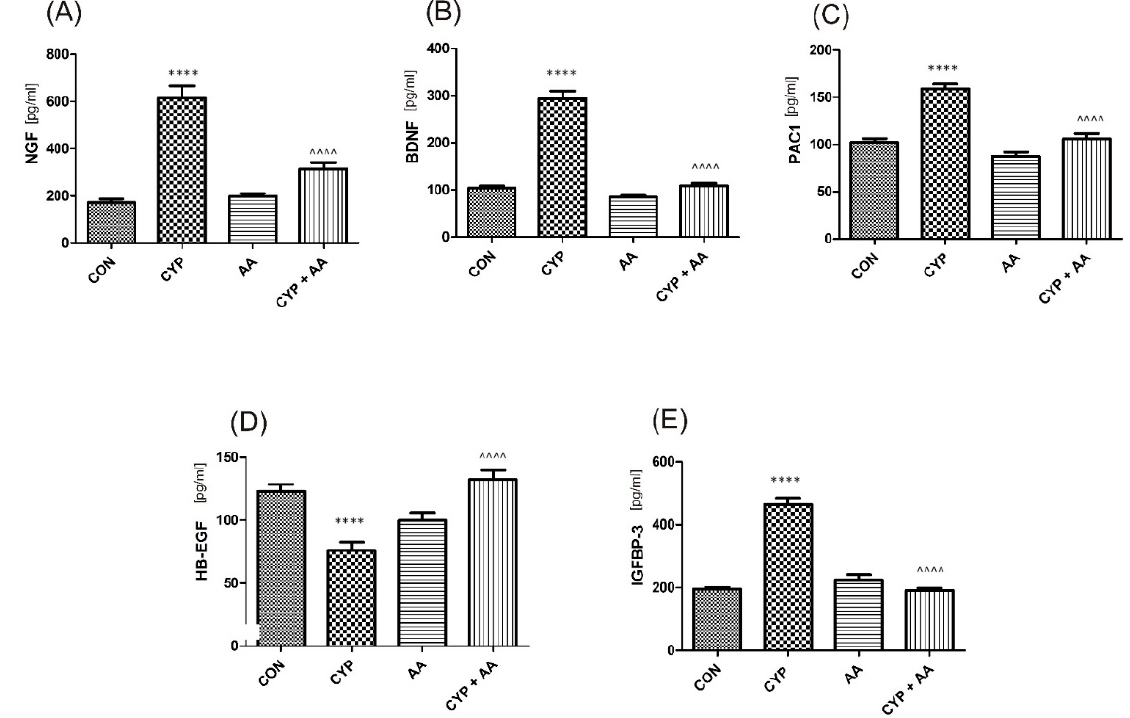
Figure 4. The effect of the two-week administration of asiatic acid (30 mg/kg/day for 14 days by oral gavage) on biomarkers in urothelium or in bladder detrusor muscle: ( A ) nerve growth factor (NGF), ( B ) brain-derived neurotrophic factor (BDNF), ( C ) PAC1 receptor (PAC1), ( D ) heparin-binding epidermal growth factor-like growth factor (HB-EGF), and ( E ) insulin-like growth factor-binding protein 3 (IGFBP-3) in animals that were administered with a single injection of cyclophosphamide (CYP, 200 mg/kg, intraperitoneally). All results are presented as the mean ± SEM (n = 15 rats per group). The obtained data were assessed by the one-way ANOVA followed by Tukey’s post hoc test. * when significantly different from the control group. ˆ when significantly different from the CYP group. **** or ˆˆˆˆ p < 0.0001. One-way ANOVA: for NGF F(3.56) = 45, p < 0.0001, for BDNF F(3.56) = 113, p < 0.0001, for PAC1 F(3.56) = 41, p < 0.0001, for HB-EGF F(3.56) = 16, p < 0.0001, and for IGFBP-3 F(3.56) = 89, p < 0.0001. AA: asiatic acid; CON: control; CYP: cyclophosphamide.